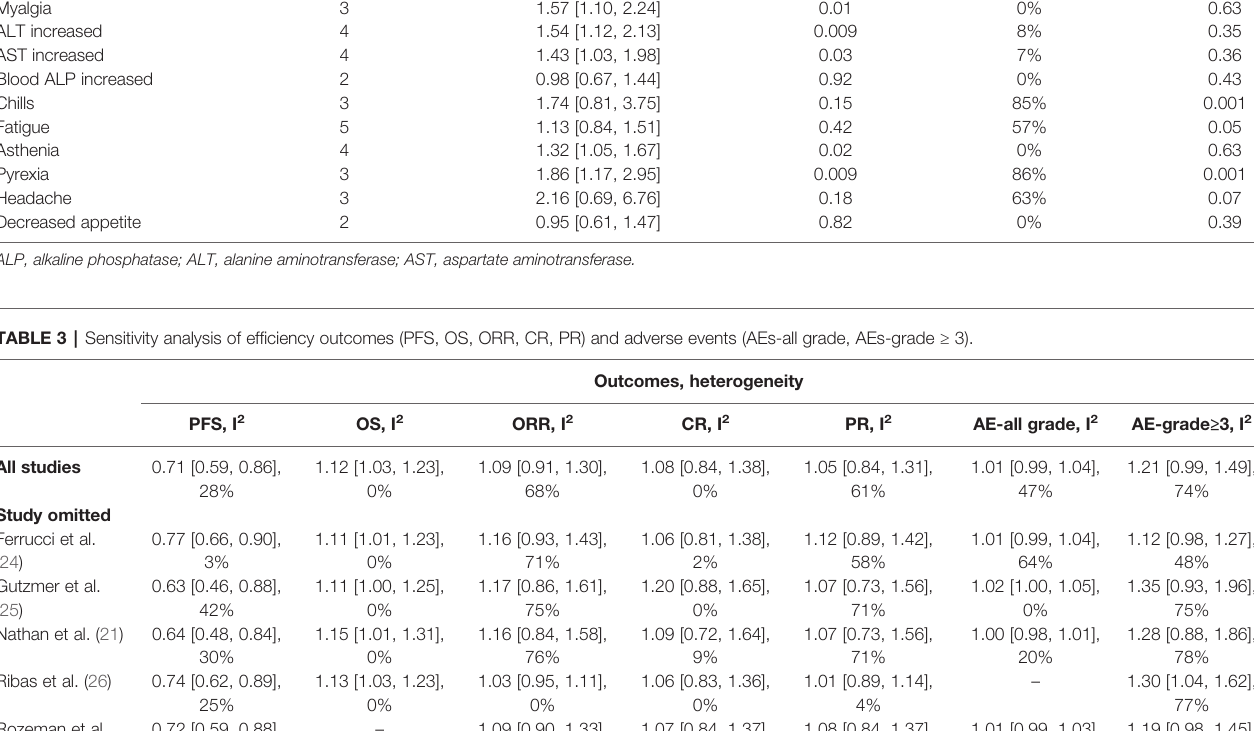
TABLE 3 | Sensitivity analysis of ef fi ciency outcomes (PFS, OS, ORR, CR, PR) and adverse events (AEs-all grade, AEs-grade ≥ 3).